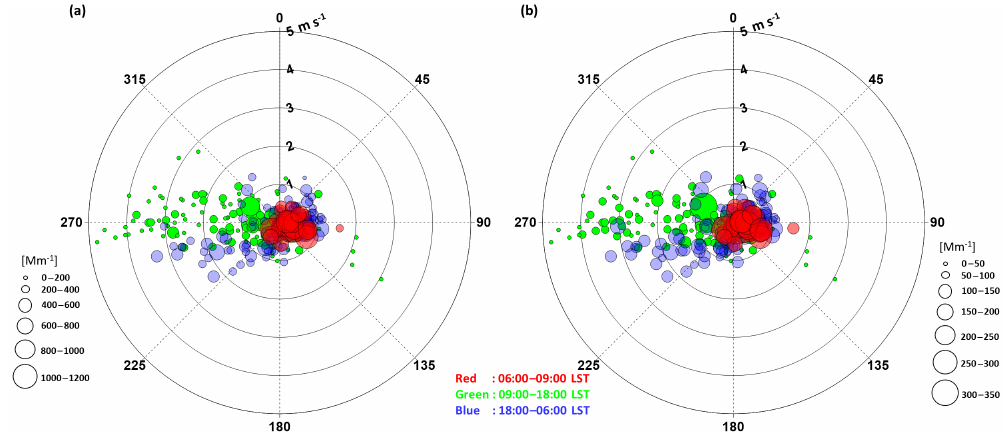
Figure 7. (a) Aerosol scattering coefficient and (b) aerosol absorption coefficient for three time periods of the day: morning (red dot; 06:00–09:00LST), day (green dot; 09:00–18:00LST), and night (blue dot; 18:00–06:00LST) for different wind speeds (ms − 1 ) and wind directions (degree).